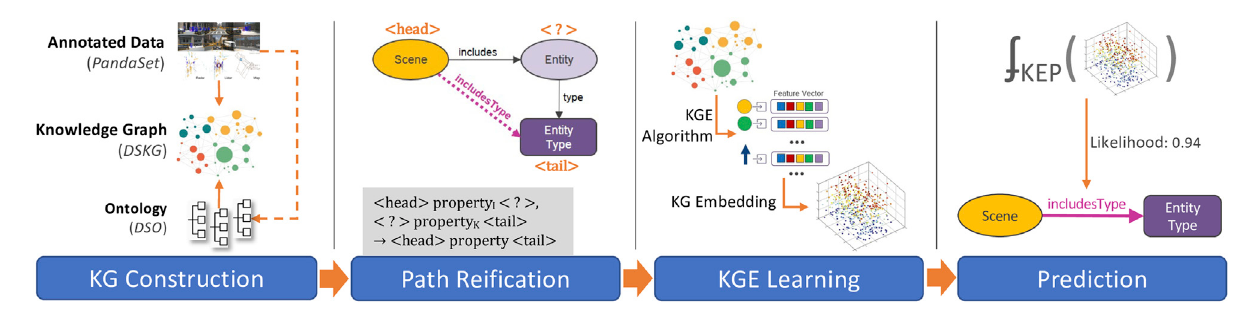
FIGURE 5 | Four main phases involved in Scene Entity Prediction (KEP) pipeline.